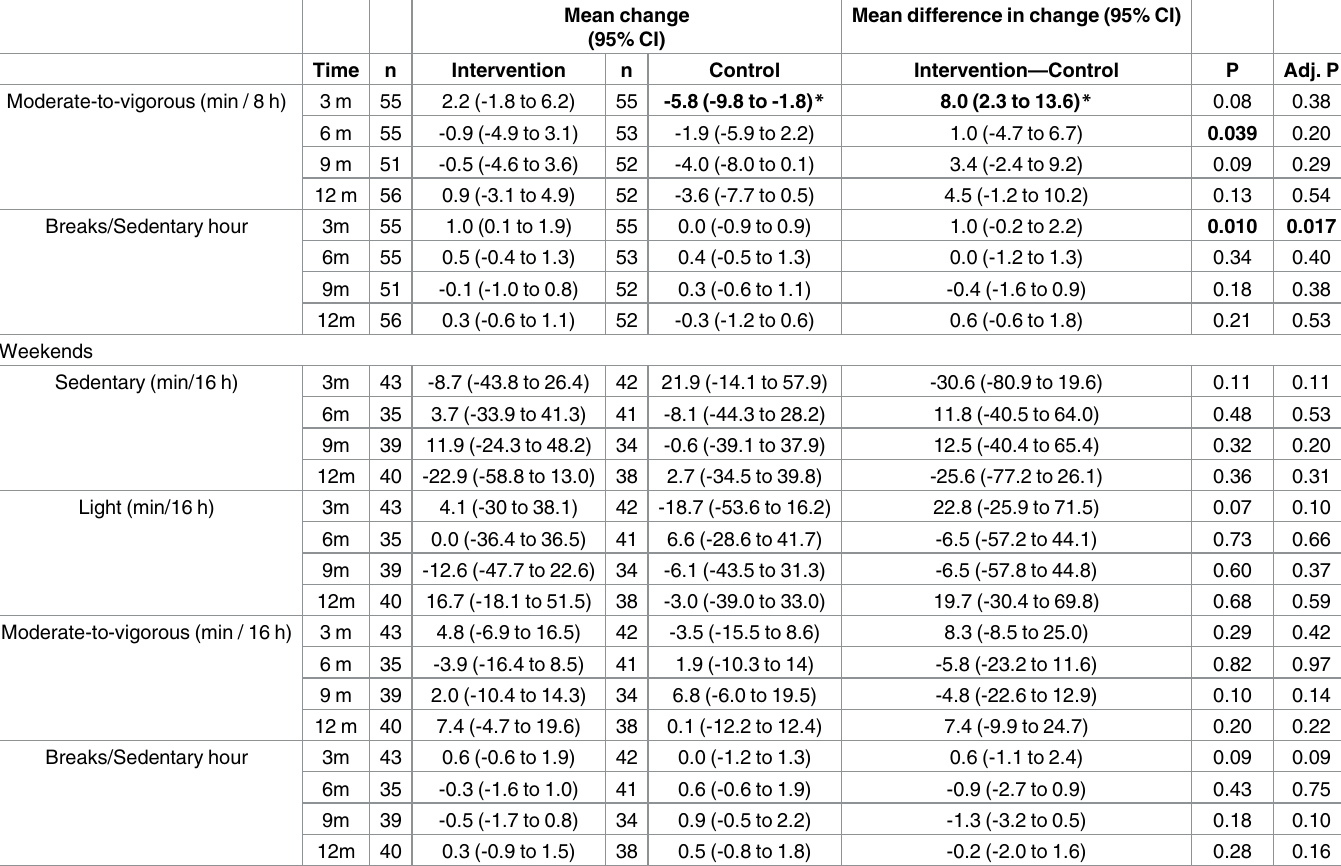
full adjustment. At three months, sedentary leisure time decreased 21.2 minutes / 8 hours more in the intervention group than the control group (P = 0.010). At the same time, leisure moderate-to-vigorous activity increased 8.0 minutes more in the intervention group than in controls (P = 0.037) due a decrease within the control group (P = 0.017). No changes at other times or in other domains were observed (Table 2 and Fig 2).